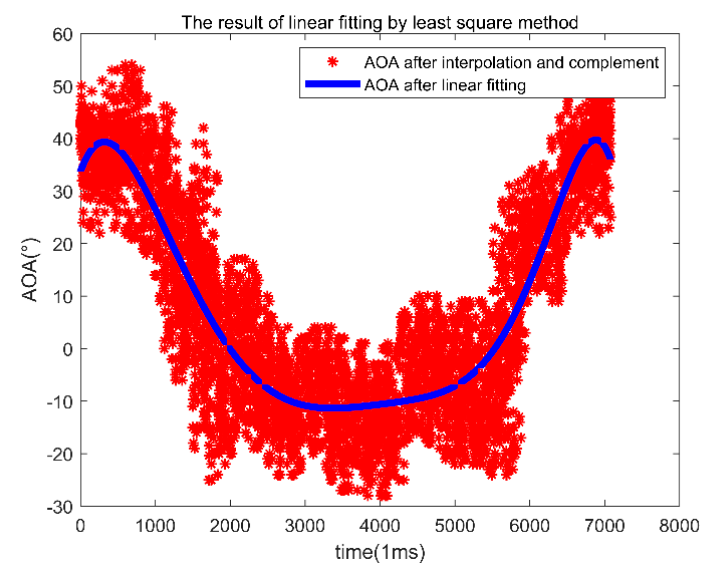
Figure 7. AOA results of linear fitting by least-squares method after value filling